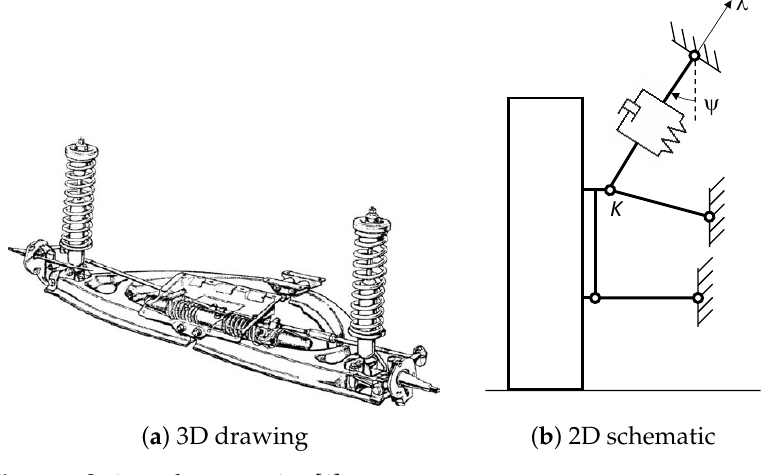
Figure 2. Swing axle suspension